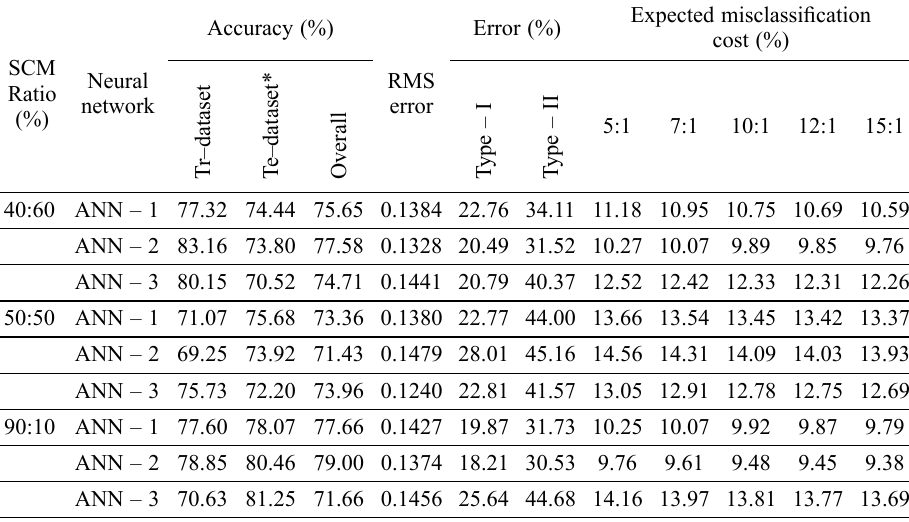
Note : * Tr–dataset and Te–dataset refer to training and testing datasets,